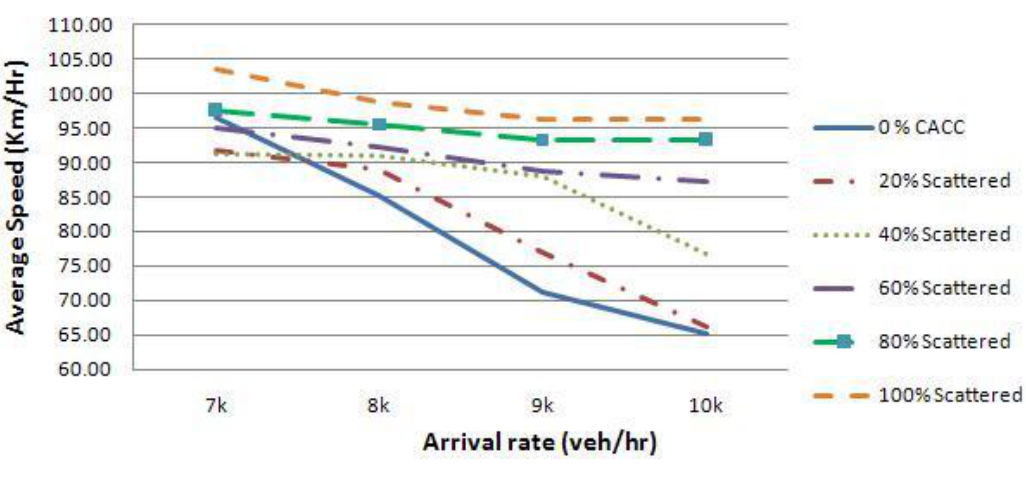
Figure 10. Average speed analysis (without a